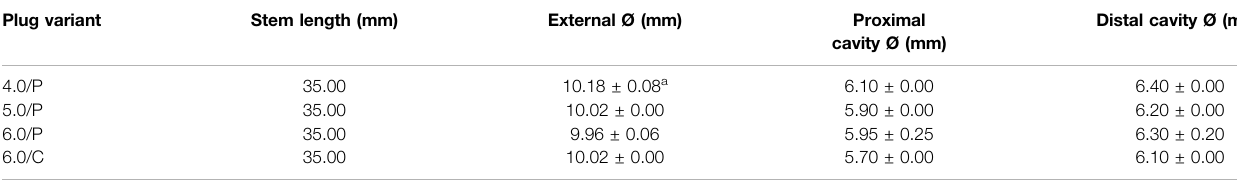
TABLE 2 | SolidWorks-designed tibiae plug variants dimensions for 9 mm diameter tibiae.